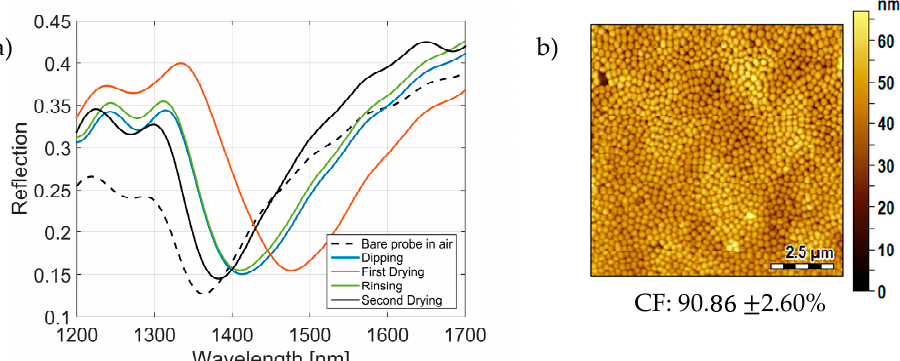
Figure 2. Characterization of the MGs film deposited following the previous procedure onto the goad coated optical fiber tip. ( a ) Reflection spectra of the LOF probes measured at the end of each fabrication step. ( b ) AFM characterization of the realized MGs film at the end of the entire procedure, pertaining to an unpatterned area of 10 × 10 µm close to the nanostructure.